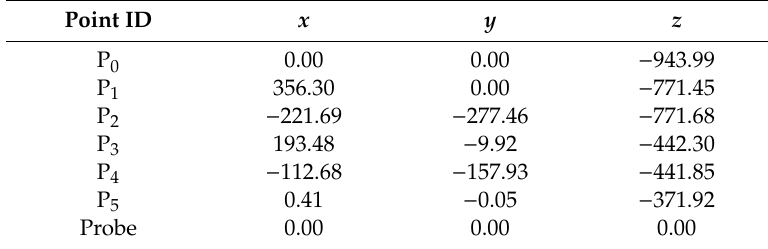
Table 2. Calibration results of the receiver array in Figure 5 (unit: mm). Here, the probe point is defined as the origin of the o-xyz frame. The direction from the probe to P0 is defined as the z axis. a line perpendicular to the z axis and passing through P1 is defined as the x axis. The direction of the y axis is defined according to the right-hand